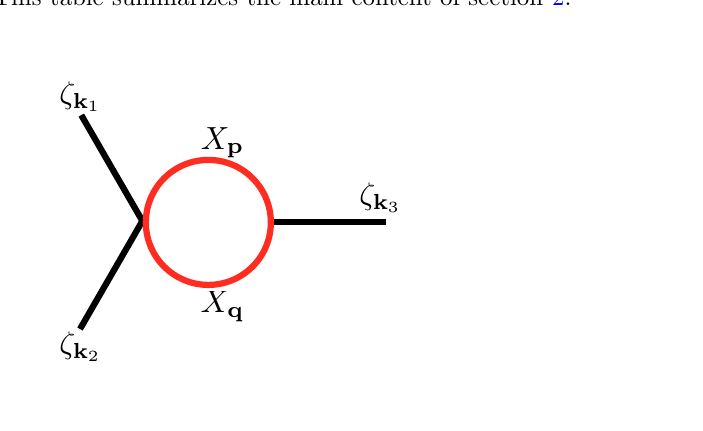
Figure 5 . The Feynman diagram that contributes to the cosmological collider signal in the squeezed limit k 3 (cid:28) k 1 (cid:24) k 2